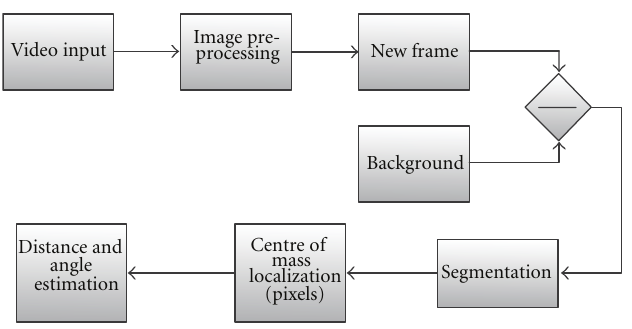
Figure 9: Flowchart of the general hardware architecture.